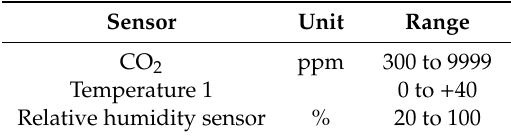
Table 2. List of measured parameters and their unit.